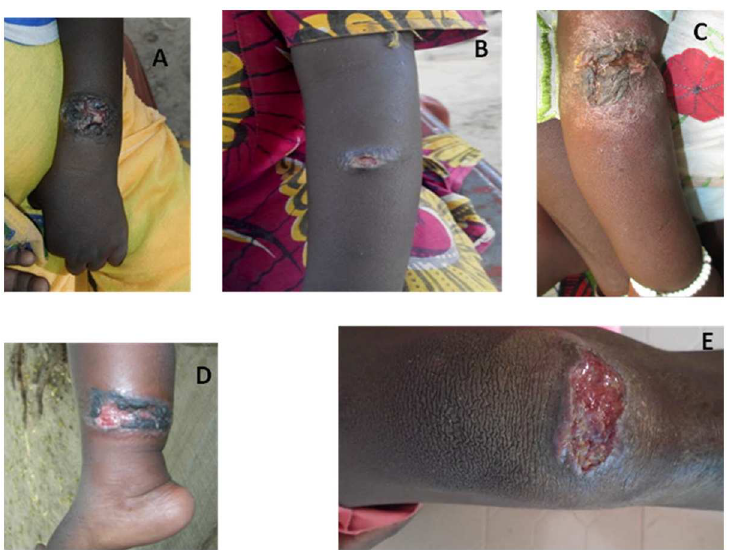
Fig 6. Images representative of active CL cases diagnosed during the study. A : Ulcero-crusted lesionof CL (3 to 4 cm diameter) on the forearm of 8 years old girl from the villageof Nafadji. B : Ulceratednoduleof CL (1.5 cm diameter) of the left forearm of 10 years old girl from the villageof Nafadji. C : Superinfected and crusted lesion of CL of the right forearm of a 3 years old girl from the villageof Guemou. Please note the dry and erythematous halo with an eczematization of the lesion. D : Ulceratedlesion of CL with black crusted lesion(covered by a local traditionalpowder) of leg of a 2 years boy from the villageof Nafadji. E : Ulcerated noduleof CL of the right knee of a 13 years old boy from the villageof Tinkare.